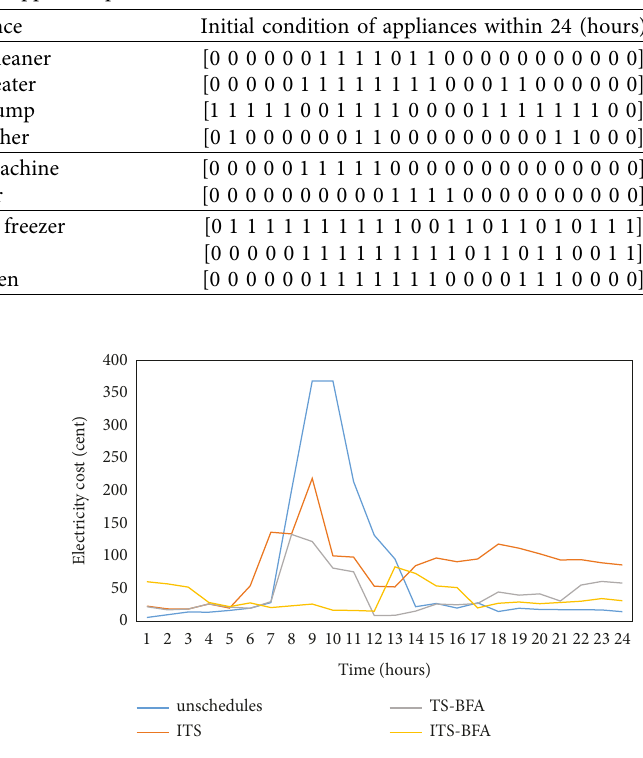
Figure 3: Load during 24 hours. Figure 4: Electricity cost based on TOU tariff during 24